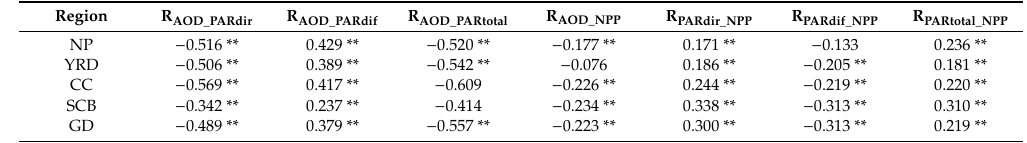
Table 4. The correlation coe ffi cients between AOD, PAR and NPP for typical regions.